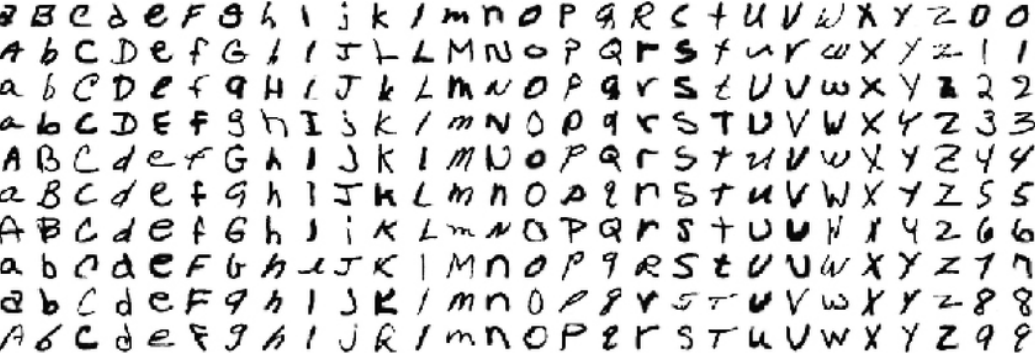
Figure 3. Examples of EMNIST dataset